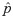
Estimated values of p, CC and DS.For each case of (a) n = 10,000 and (b) n = 20,000, 100 WS networks were generated with K = 80 and a randomly chosen p ∈ [0.005, 0.05]. From each network, s = 100 nodes were randomly sampled along with their degrees to calculate p^ from Algorithm 1. All estimated values were normalized between 0 and 1.